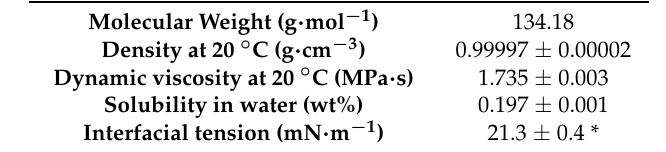
Table 2. Physicochemical properties of 4-methylacetophenone